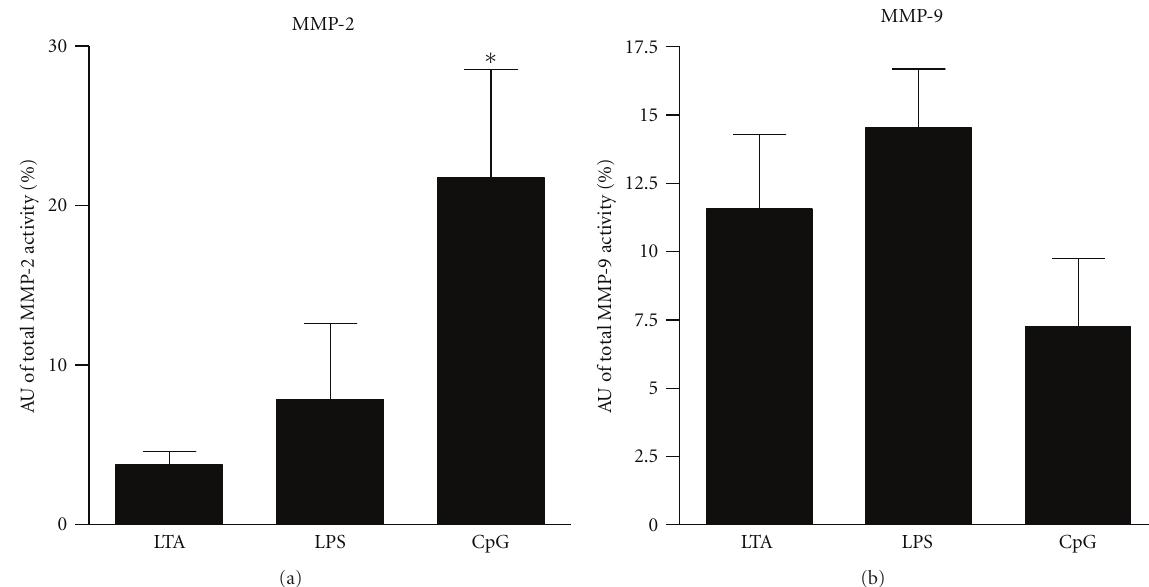
Figure 7: MMP zymographic assay. Percentage of total quantified MMP-2 or MMP-9 activity, respectively. Zymographic activity after stimulation (4h) was normalized to baseline activity (0h). Values are expressed as arbitrary densitometric units (AU; ∗ P < . 05 versus LTA and LPS; n =